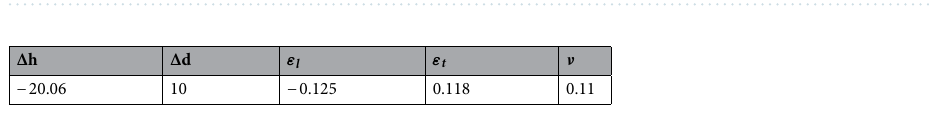
Table 8. Measured displacements, strains and Poisson’s ratio of honeycomb composite in the case of compression test.